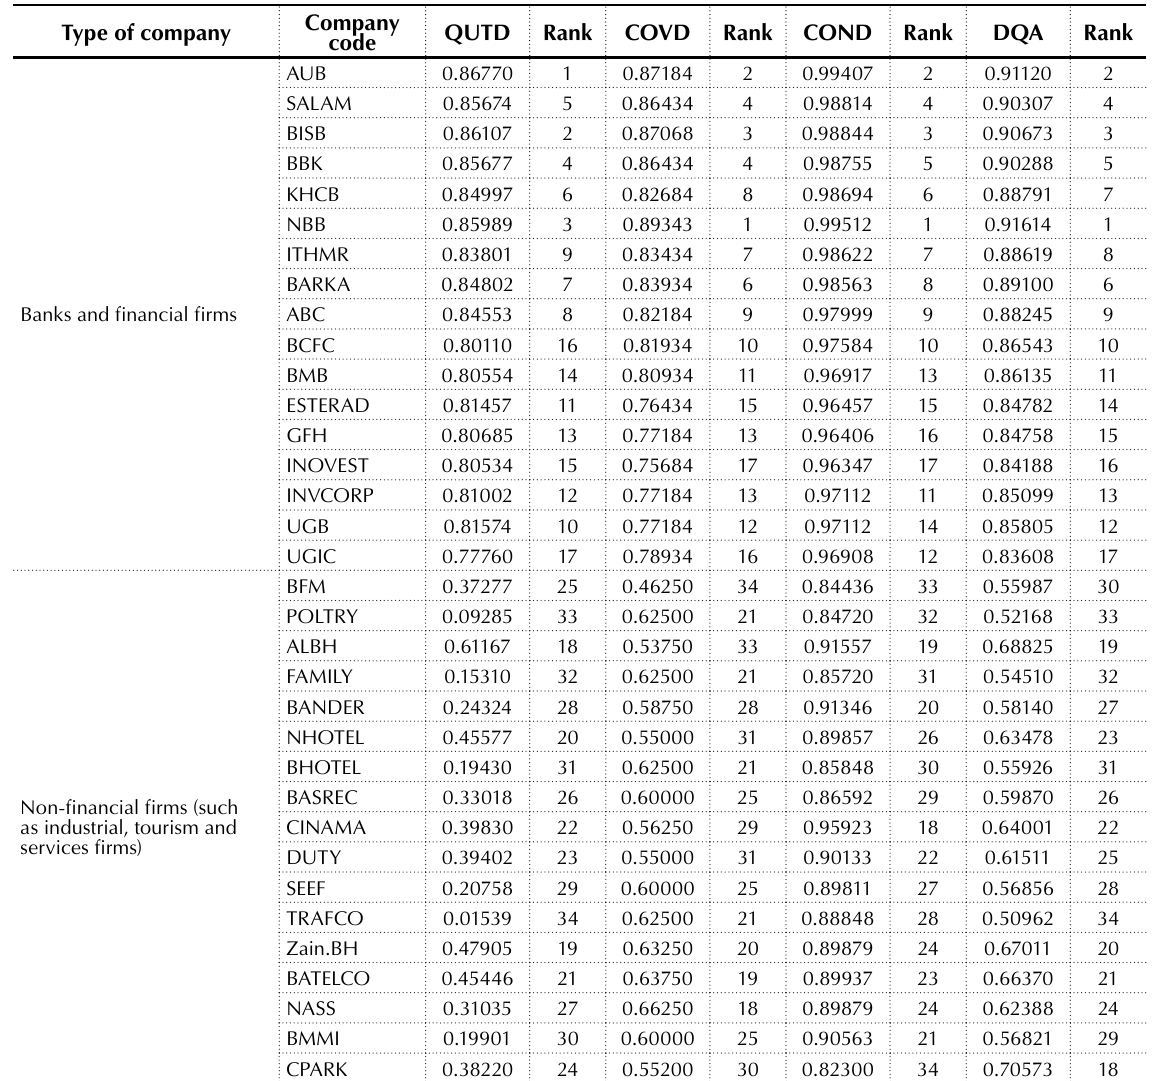
Table 4. Company ranking in year 2017 Type of